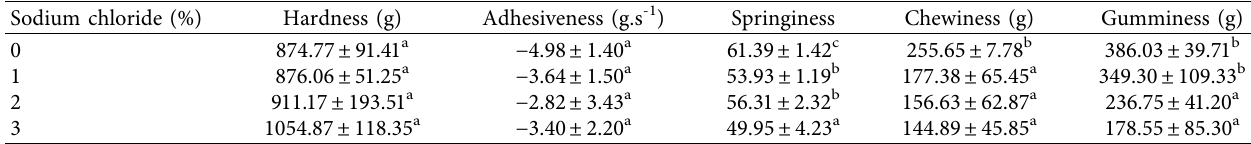
Table 2: TPA indices (mean ± SD) of Micropterus salmoides products with different sodium chloride additions. Sodium chloride (%)